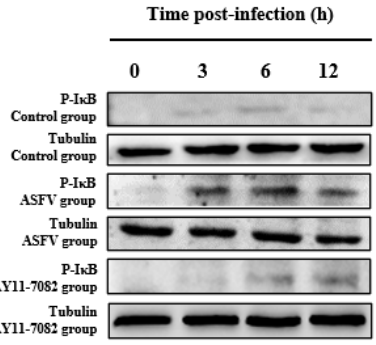
Figure 7. Effect of BAY11-7082 on p-I κ B protein after ASFV infection. Western blotting was used to measure the expression of the p-I κ B protein in the cytoplasm at 3, 6, and 12 h in each group of PAMs. Levels of p-I κ B increased after ASFV infection relative to controls, and this effect was abrogated by the NF- κ B inhibitor BAY11-7082. Tubulin expression was used as a positive control.